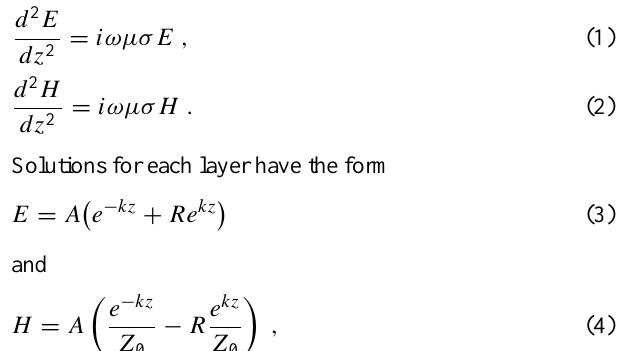
Fig. 1. The process of calculating a pipeline response to geo- magnetic